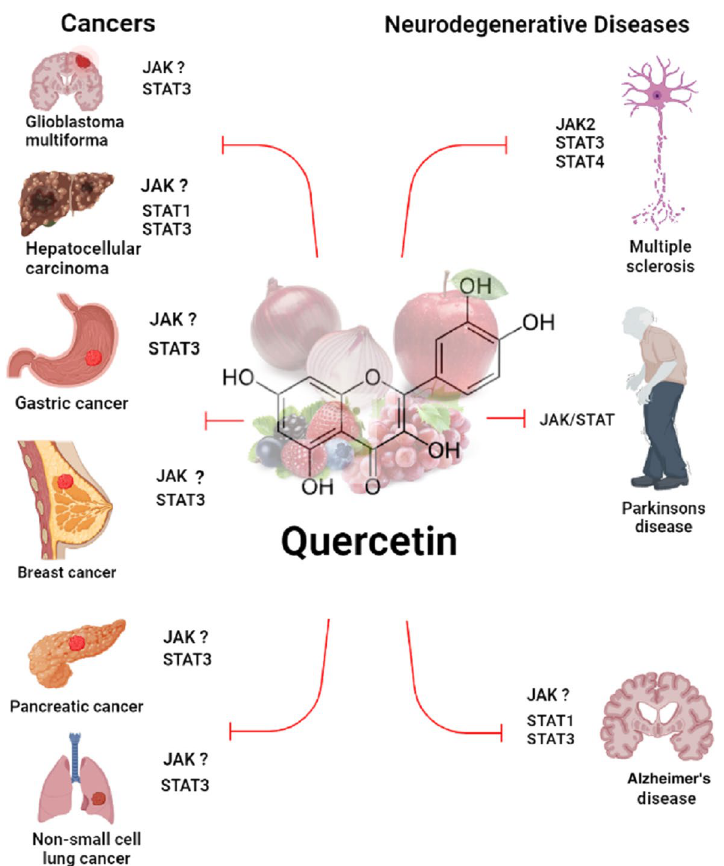
Fig. 1 Therapeutic effects of quercetin on inhibiting the JAK–STAT signaling pathways in cancers and neurodegenerative